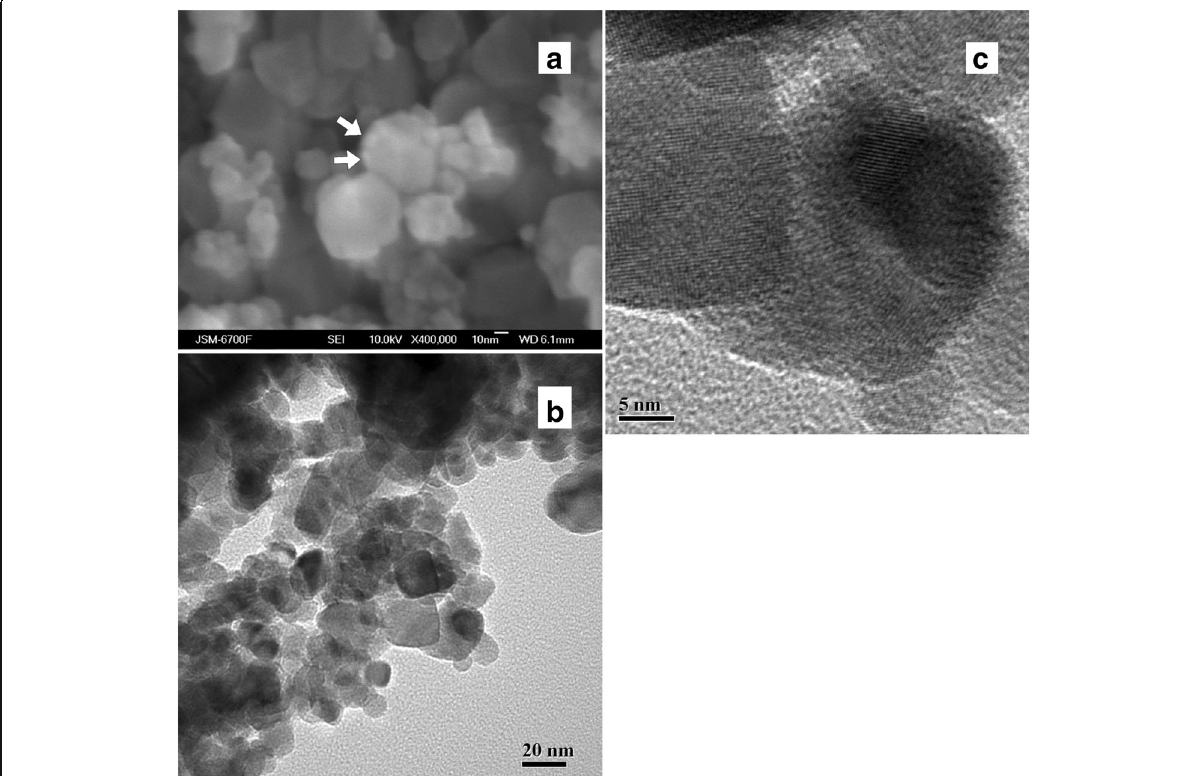
Fig. 3 a FESEM and b , c HRTEM images of the sensor Pd/SnO 2